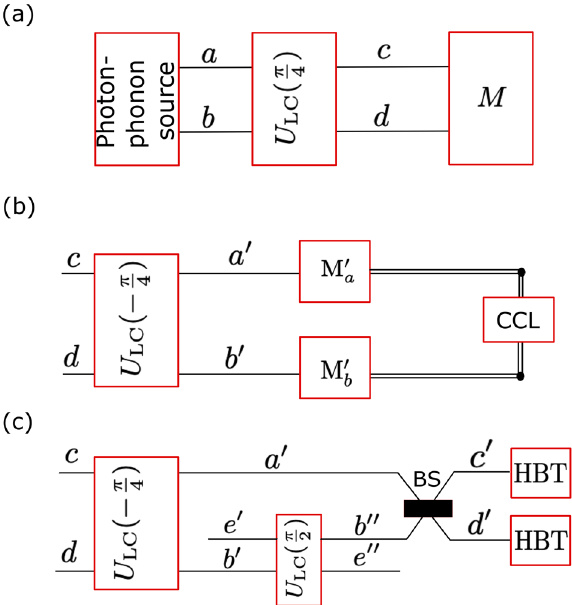
Figure 13. Schematics of the proposed detection schemes: ( a ) General scheme for the generation of the photonic mode a , phononic mode b , and hybrid modes c , d , and their detection in the measurement unit M , which is shown in specific implementations using: ( b ) detection method 1 and ( c ) detection method 2. Key: U LC (θ) stands for the linear-coupler transformation, which in special cases corresponds to multi-level SWAP π/ 2 ) and Hadamard-like (for θ π/ 4 ) gates; BS is the balanced beam splitter, which corresponds (for θ = = ± to U LC (π/ 4 ) , M ′ a ( M ′ b ) is a measurement unit for detecting photons (phonons), CCL is a coincidence and count